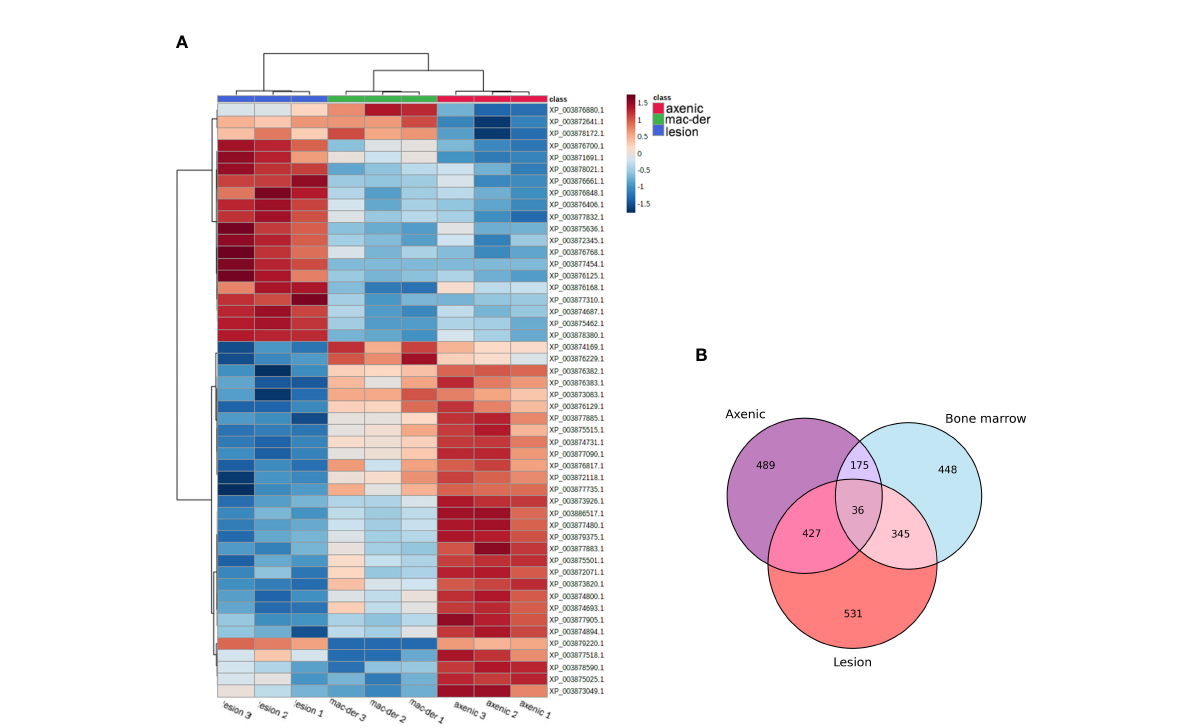
FIGURE 2 (A) Hierarchical Clustering Heat map representing the top 50 differentially expressed proteins in different amastigote type with biological triplicate. The protein abundance was normalized to enable the comparison of data obtained from LC-MS/MS. The MetaboAnalyst 5.0 website was used for data normalization and to generate the fi gure. The lines in the heatmap represent the relative abundance of metabolites across the samples of the three compared groups (lesion-derived, macrophage-derived, and axenic amastiogtes); each protein ID is indicated on the right side of the fi gure. The columns corresponding to the amastigote type are indicated at the top by color (blue for les-derived amastigotes, green for macrophage-derived amastigotes, and blue for axenic amastigotes). Each of the nine columns corresponds to one biological replicate (three per amastigote type). On the upper right side of the fi gure is a scale indicating the color code relative to the normalized protein abundance (ranging from -1.5 to 1.5). (B) Venn diagram indicates the overlap of differentially expressed proteins between amastigote